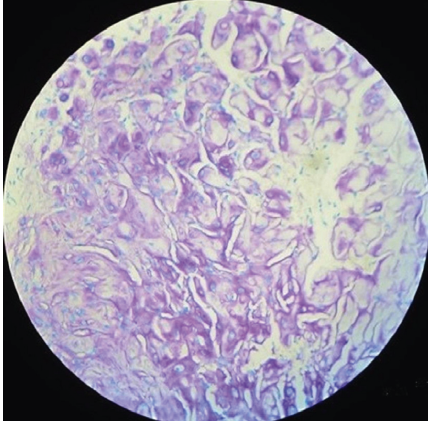
Figure 7: Toluidine blue staining showing typical metachromasia of cartilage.